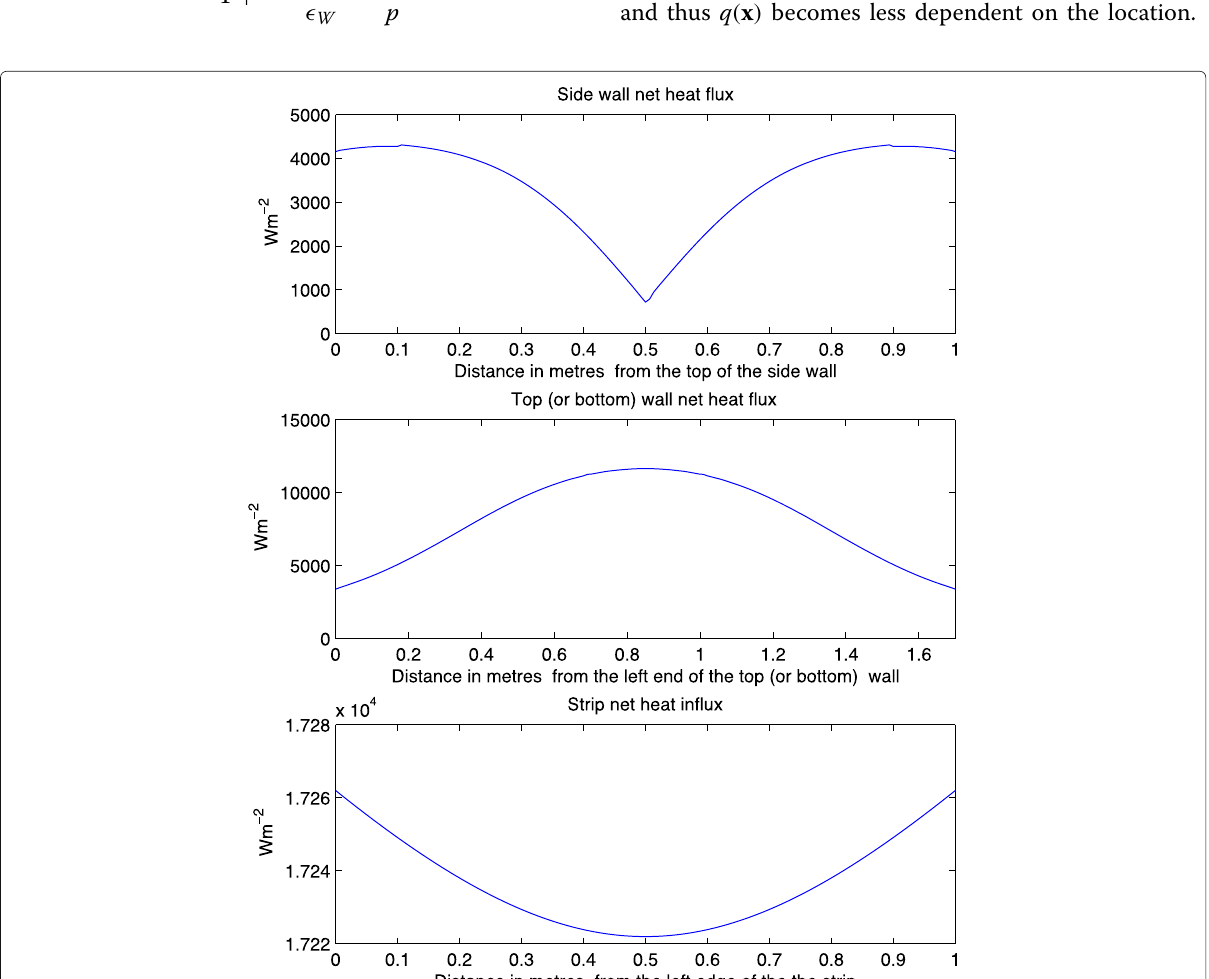
Fig. 9 Net heat influx on the strip and the wall